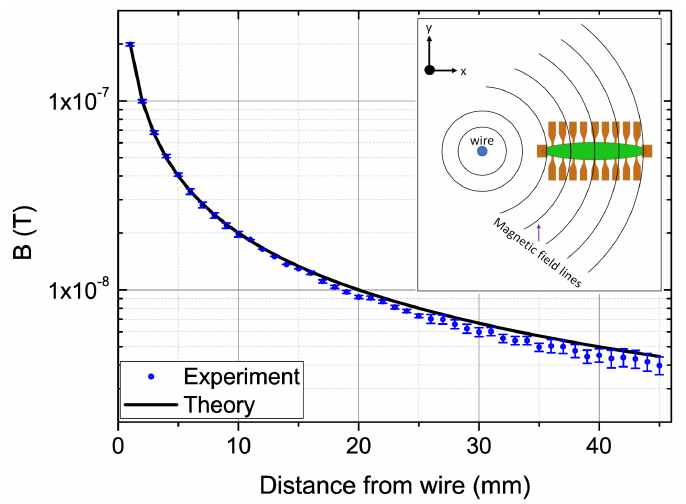
Figure 4. The variation of the magnetic field from a current-carrying wire with a distance from the wire (measured outside the magnetic shield) with an EPHEG along with the calculated magnetic field. The standard deviation of 10 measurements is presented as the error at each point. The inset depicts the schematics of the measurement setup. The current-carrying wire is in the z-direction perpendicular to the plane of the figure.